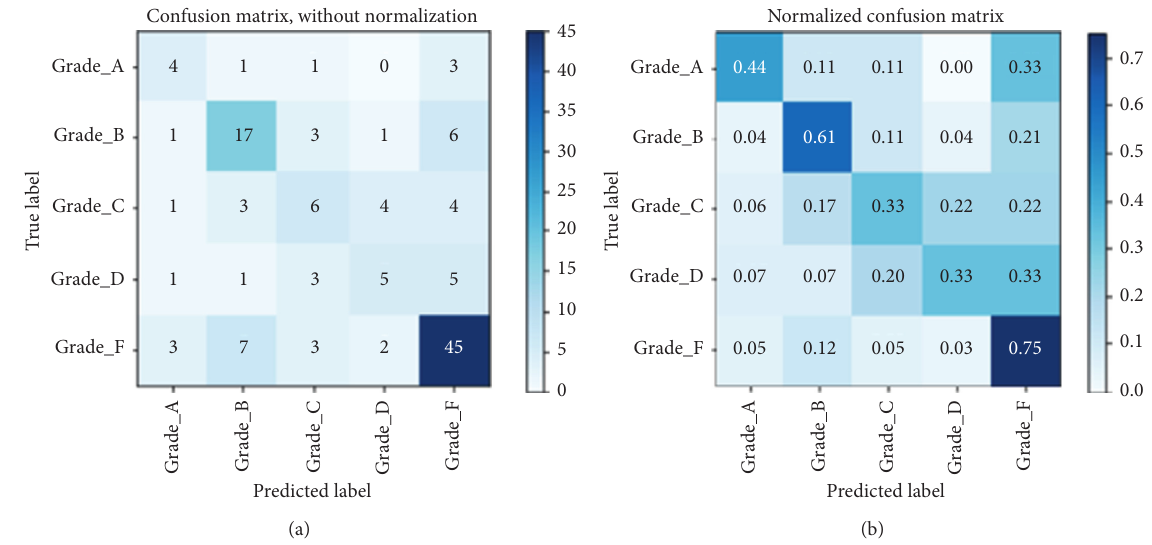
Figure 9: Confusion matrices of M-learning model 2, without normalization and normalized confusion matrix. (a) Without normalization. (b) With